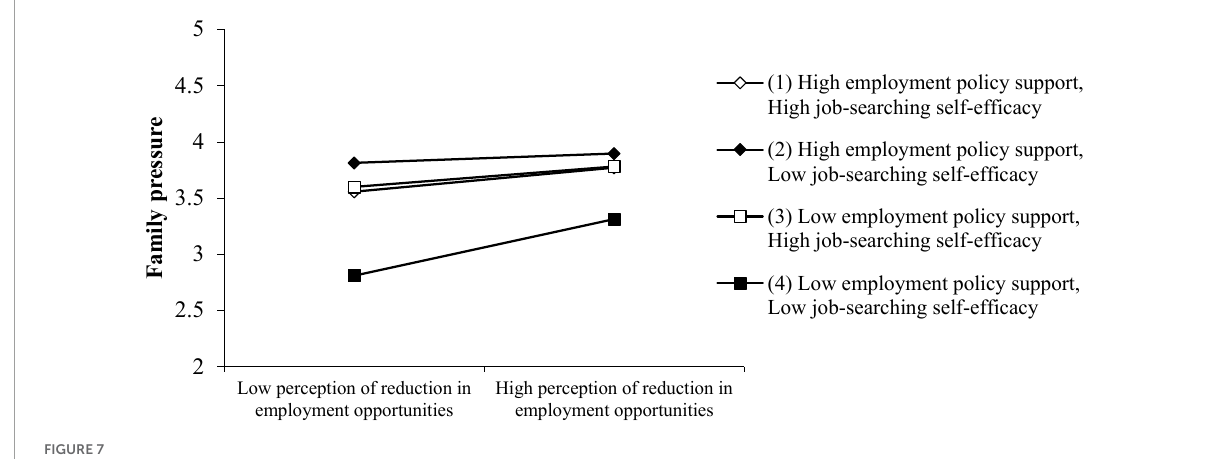
FIGURE7 The joint-moderating effect of employment policy support and job-searching self-efficacy on the perception reduction of employment opportunities and family